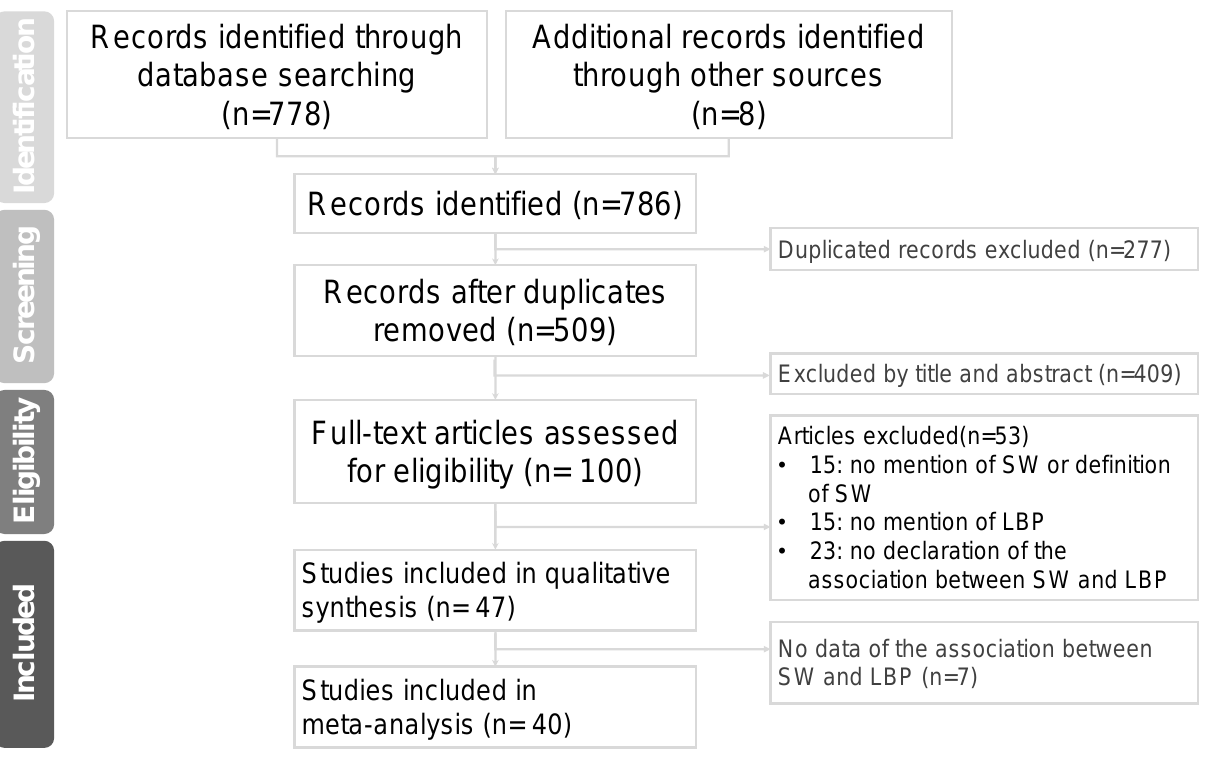
Figure 1. Figure 1. Preferred Reporting Items for Systematic Reviews and Meta-Analyses (PRISMA) flow diagram. SW, shift work; LBP, low back